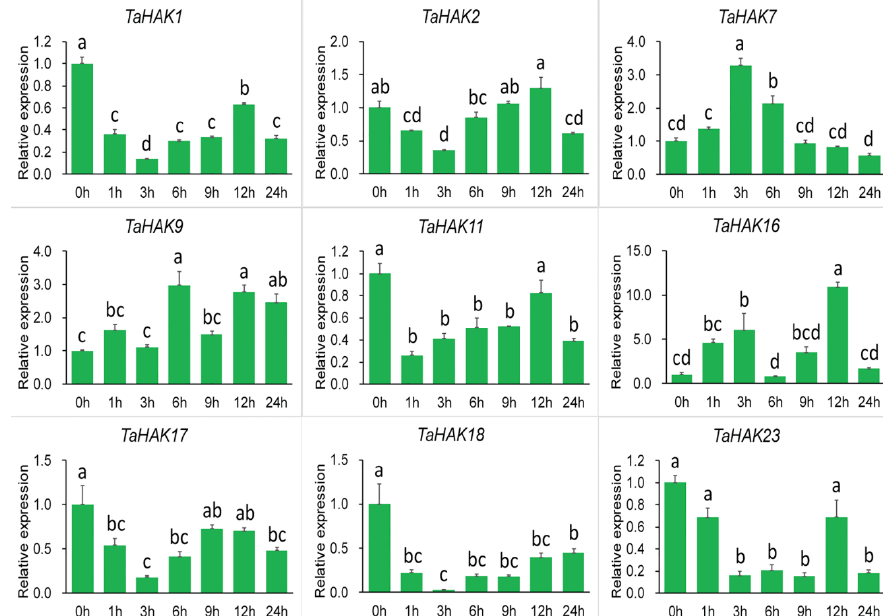
Figure 6. Expression of TaHAK genes in response to salt stress (200 mM NaCl). Expression of TaHAK genes was determined by qRT-PCR using total RNA isolated from wheat roots at different time points (0, 1, 3, 6, 9, 12 and 24 h) of salt stress. One-way ANOVA with Duncan’s multiple range test was conducted using SPSS version 20.0. Different letters on top of error bars indicate significant differences at p = 0.05 level. Error bars indicate the SE of three replicates. Int. J. Mol. Sci. 2018 , 19 , x